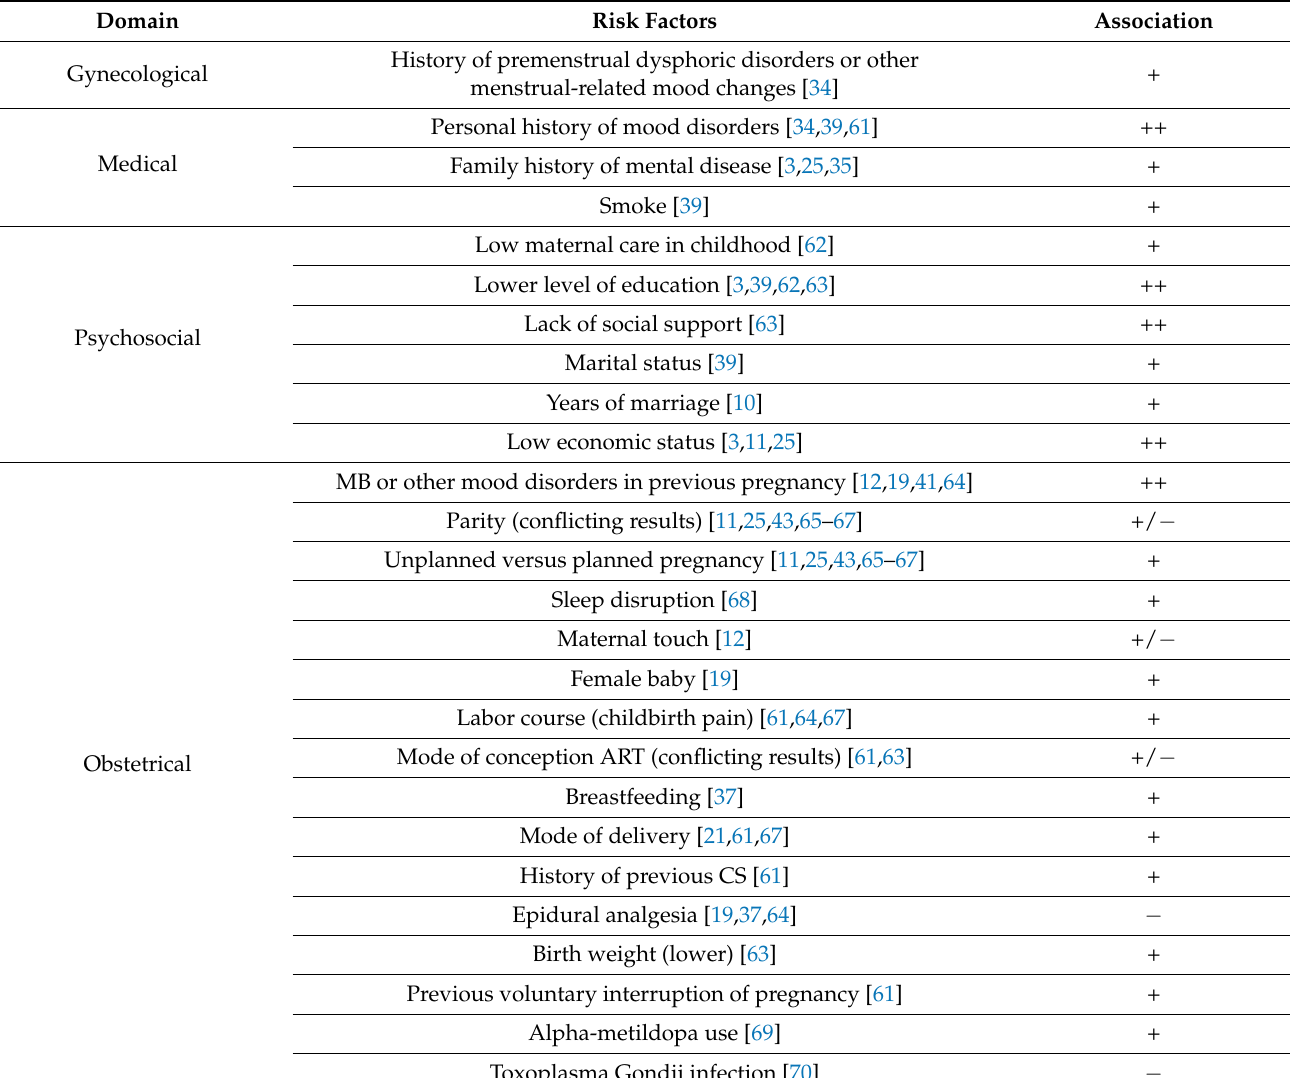
Table 3. Risk factors for